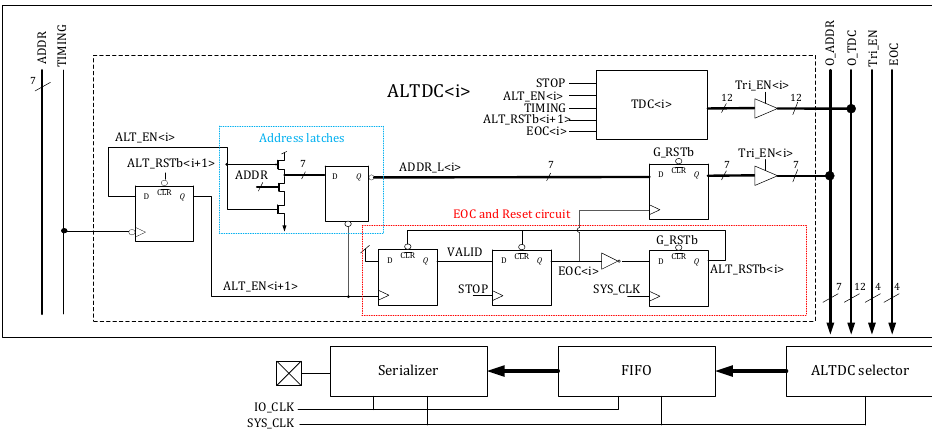
Figure 5. ALT schematic with the main functionality circuit and interface to the readout block.